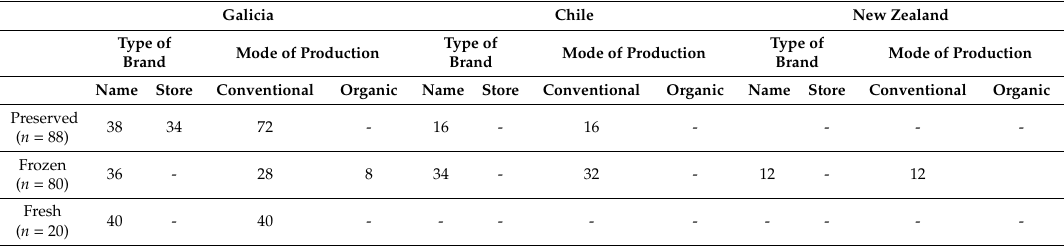
Table 1. Sampling of the mussels according to the type of conservation, the production area, the type of brand, and the method of